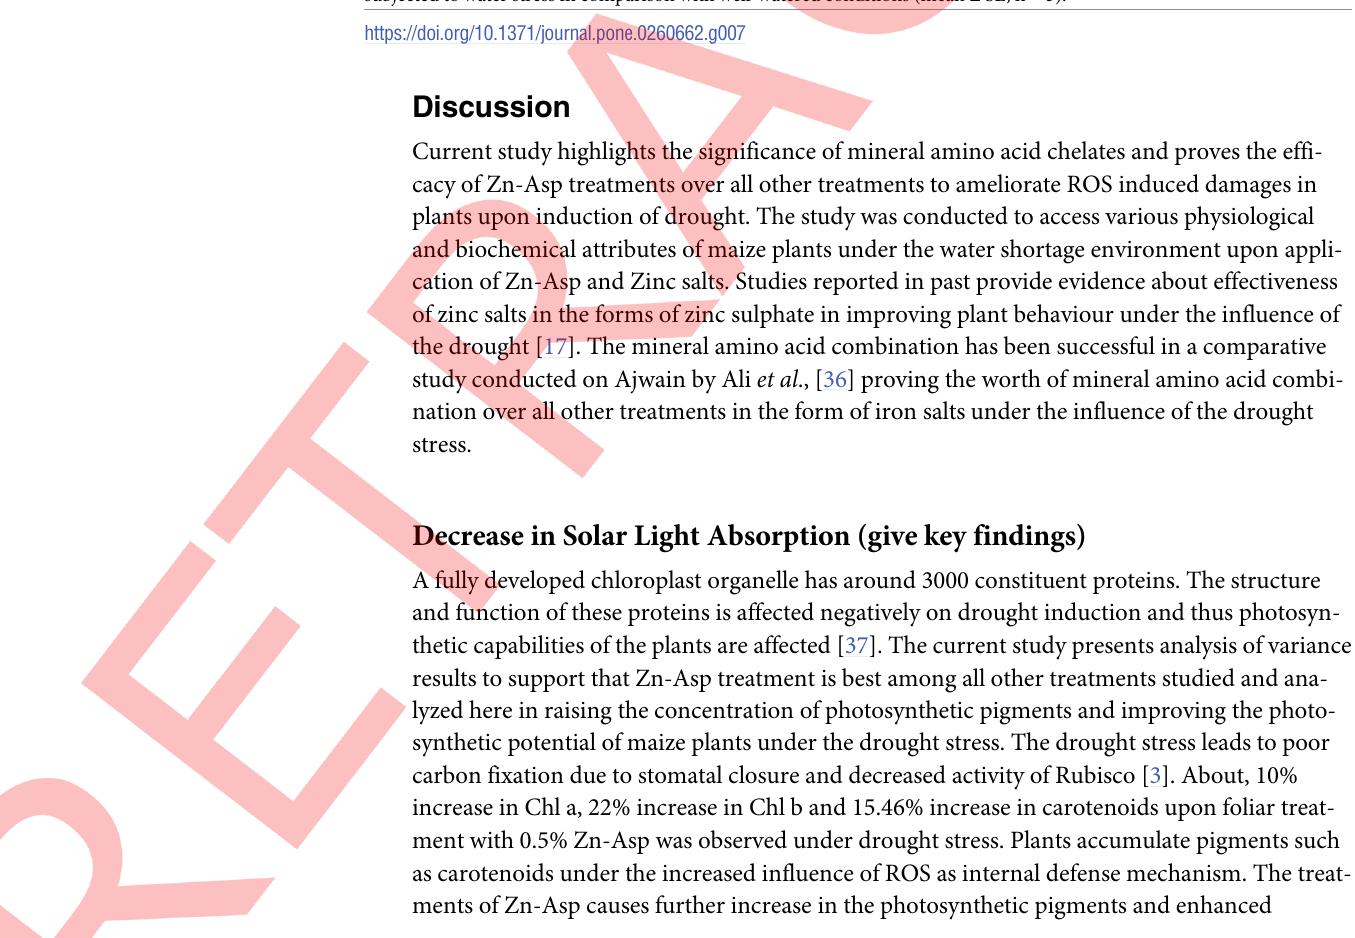
Fig 7. Effect of foliar sprinkled treatments of ZnSO 4 , Zn-Asp and L-Asp on status of (A) Free Anthocyanin (B) Bound Anthocyanin (C) Total Flavonoids (D) Total soluble sugars (E) Reducing and (F) Non Reducing sugars of maize plants subjected to water stress in comparison with well-watered conditions (mean ± SE; n =